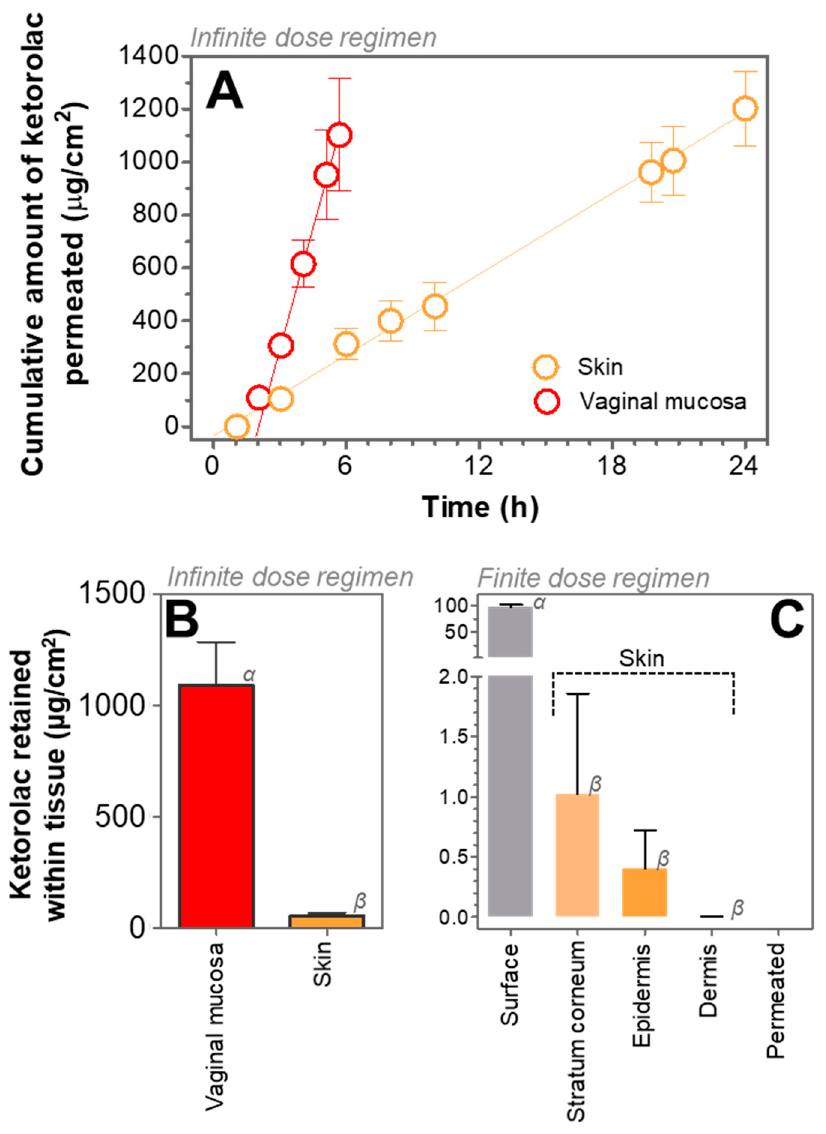
Figure 5. ( A ) Cumulative amount of ketorolac permeated ( μ g/cm 2 ) through human skin and through vaginal mucosa upon application of KT hydrogel. ( B ) Total amount of ketorolac retained within the tissue ( μ g/g cm 2 ) (skin or vaginal mucosa) 24-h after application of KT hydrogel under an infinite dose regimen. ( C ) Biodistribution of ketorolac 24 h after application of KT hydrogel using a finite dose regimen. Around 95% ketorolac remains outside the skin while the successfully penetrated ketorolac is retained within the stratum corneum and epidermis layers. All values represent Means ± SD ( n = 6). Different Greek letters represent significant differences ( p < 0.001). Permeation of ketorolac across different tissues (skin or vaginal mucosa) upon appli- cation of KT hydrogel showed significant differences. In case of permeation across skin tissue, the permeation parameters indicate that ketorolac permeation reached the steady state from the very beginning, with an estimated T lag of 0.67 h, and showing a transdermal flux of 50.92 μ g/h·cm 2 , leading to a total amount of ketorolac permeated of 1202.46 μ g/cm 2 after 24 h. In contrast, permeation through vaginal mucosa indicated a slightly longer Tlag (2.04 h) while a significantly higher flux (306.00 μ g/h·cm 2 ) led to a similar amount of ke- torolac permeated (1102.20 μ g/cm 2 ) in only 6 h. Table 2. Transdermal/transmucosal permeation parameters of ketorolac 24 h/6 h after application of KT hydrogel under an infinite dose regimen. Results are expressed as Mean ± SD ( n = 6). A P :